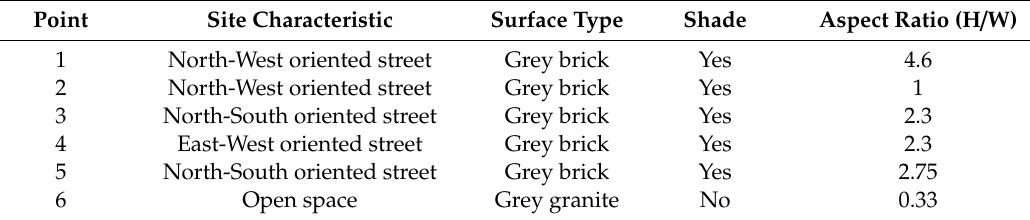
Table 2. Characteristics of the selected points [18].